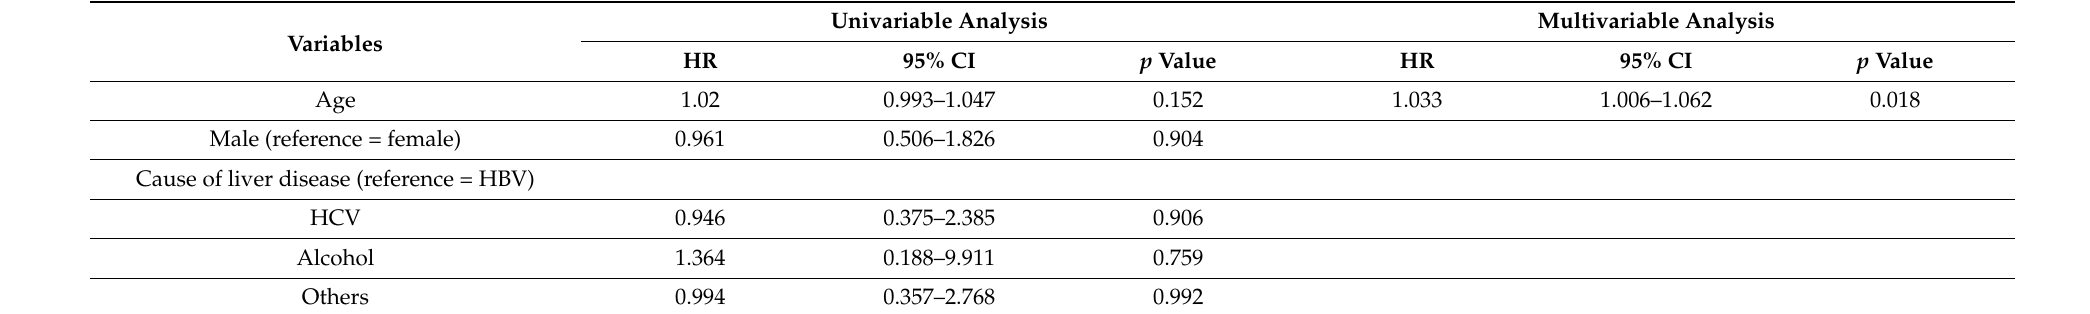
Table 4. Univariate and multivariate analysis using stepwise variable selection for prediction of early tumor recurrence.